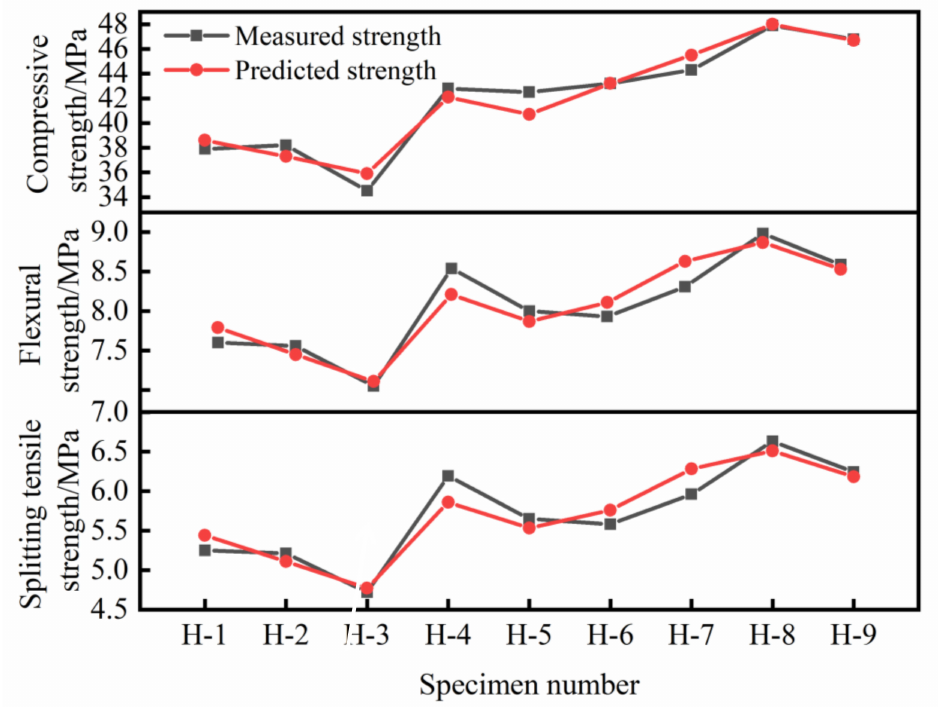
Figure 8. The predicted value and the measured value of HFRC